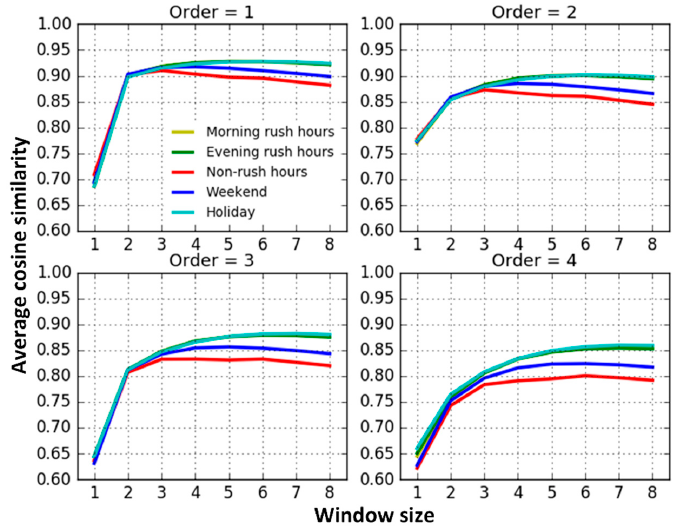
Figure 4. Average cosine similarities between (cid:1866) (cid:3047)(cid:3035) -order neighboring road segments’ vectors.